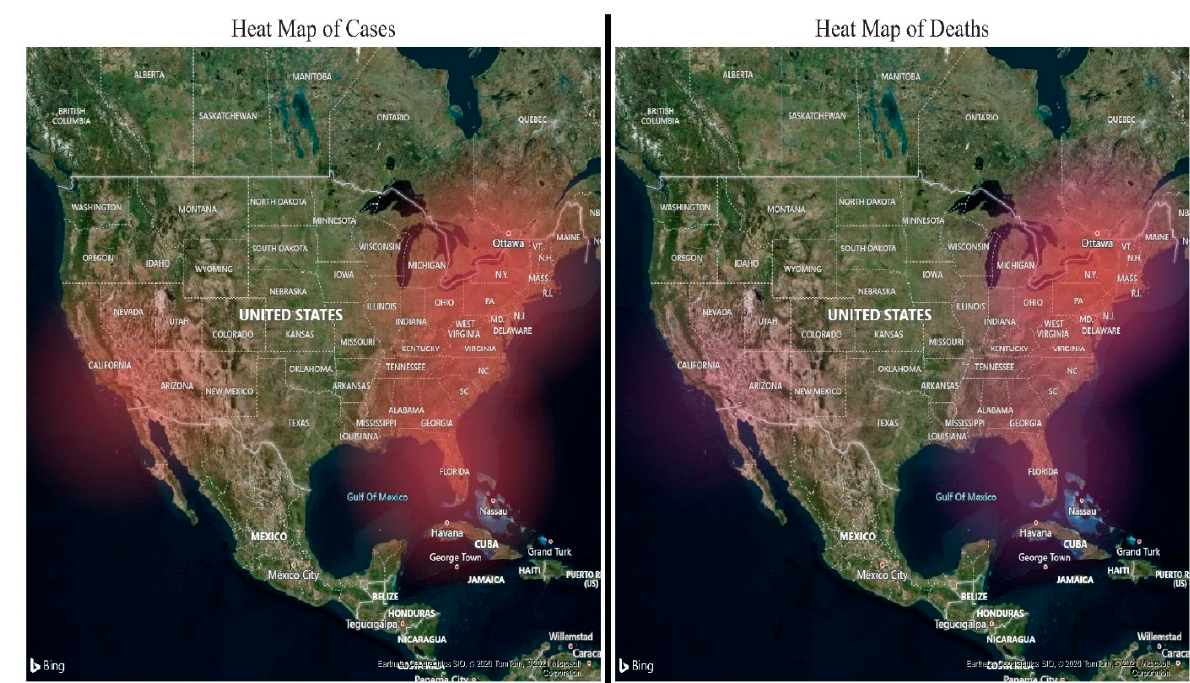
Figure 9. Heat map: spread of SARS-CoV-2 cases and deaths in five different regions of the USA.